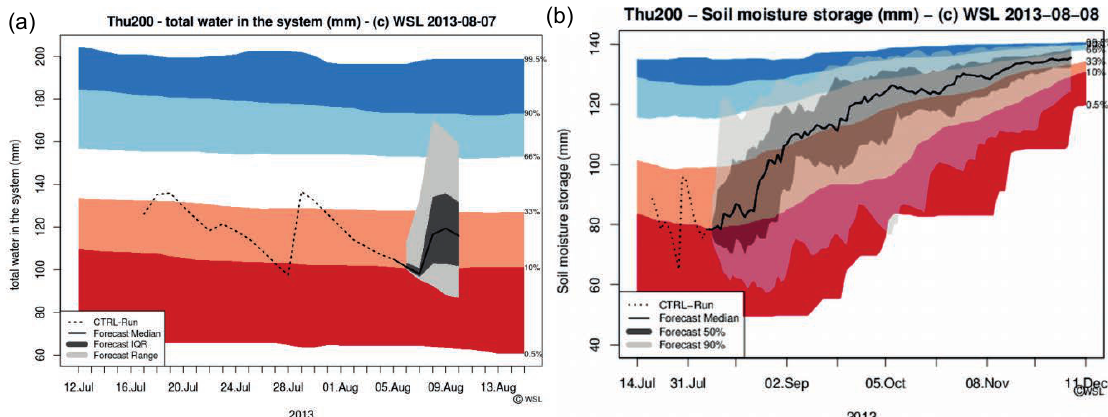
Fig. 3 Operational forecasting of total water resources (a) and soil moisture (b) for the Thur basin. The real-time five-day probabilistic forecasts forced by COSMO-LEPS (a) and the 120 climatology- predictions (b) are embedded into the long-term climatology for easy assessment of water shortages. Both forecasts were issued in early August 2013, after a relatively dry period. The visualization includes information on the recent past